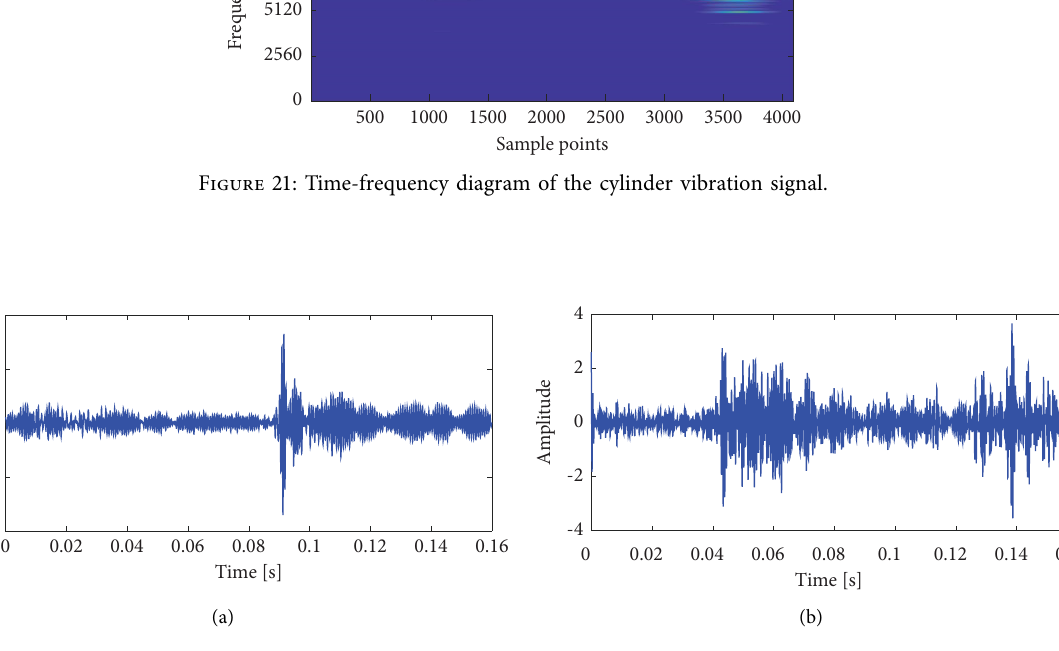
Figure 22: Reconstructed signal diagram. (a) An early reconstruction signal. (b) A late reconstruction signal.